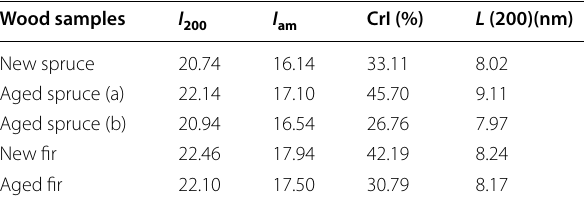
Table 4 Band positions of crystalline and amorphous cellulose and the calculated parameters for the wood samples. I is the maximum intensity of the crystalline 200 cellulose, I is the minimum intensity of the crystalline am cellulose, CrI is the crystalline index and L represents the crystallite size